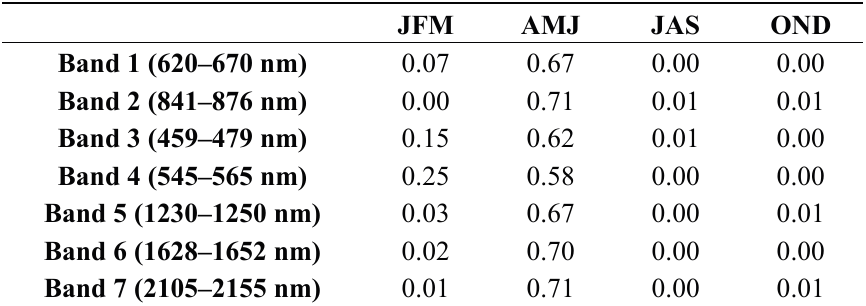
Table 4. Coefficient of determination (R 2 ) for chl- a ( μ g/L) and reflectance values from each band for four periods of the year: January to March (JFM), April to June (AMJ), July to September (JAS) and October to December